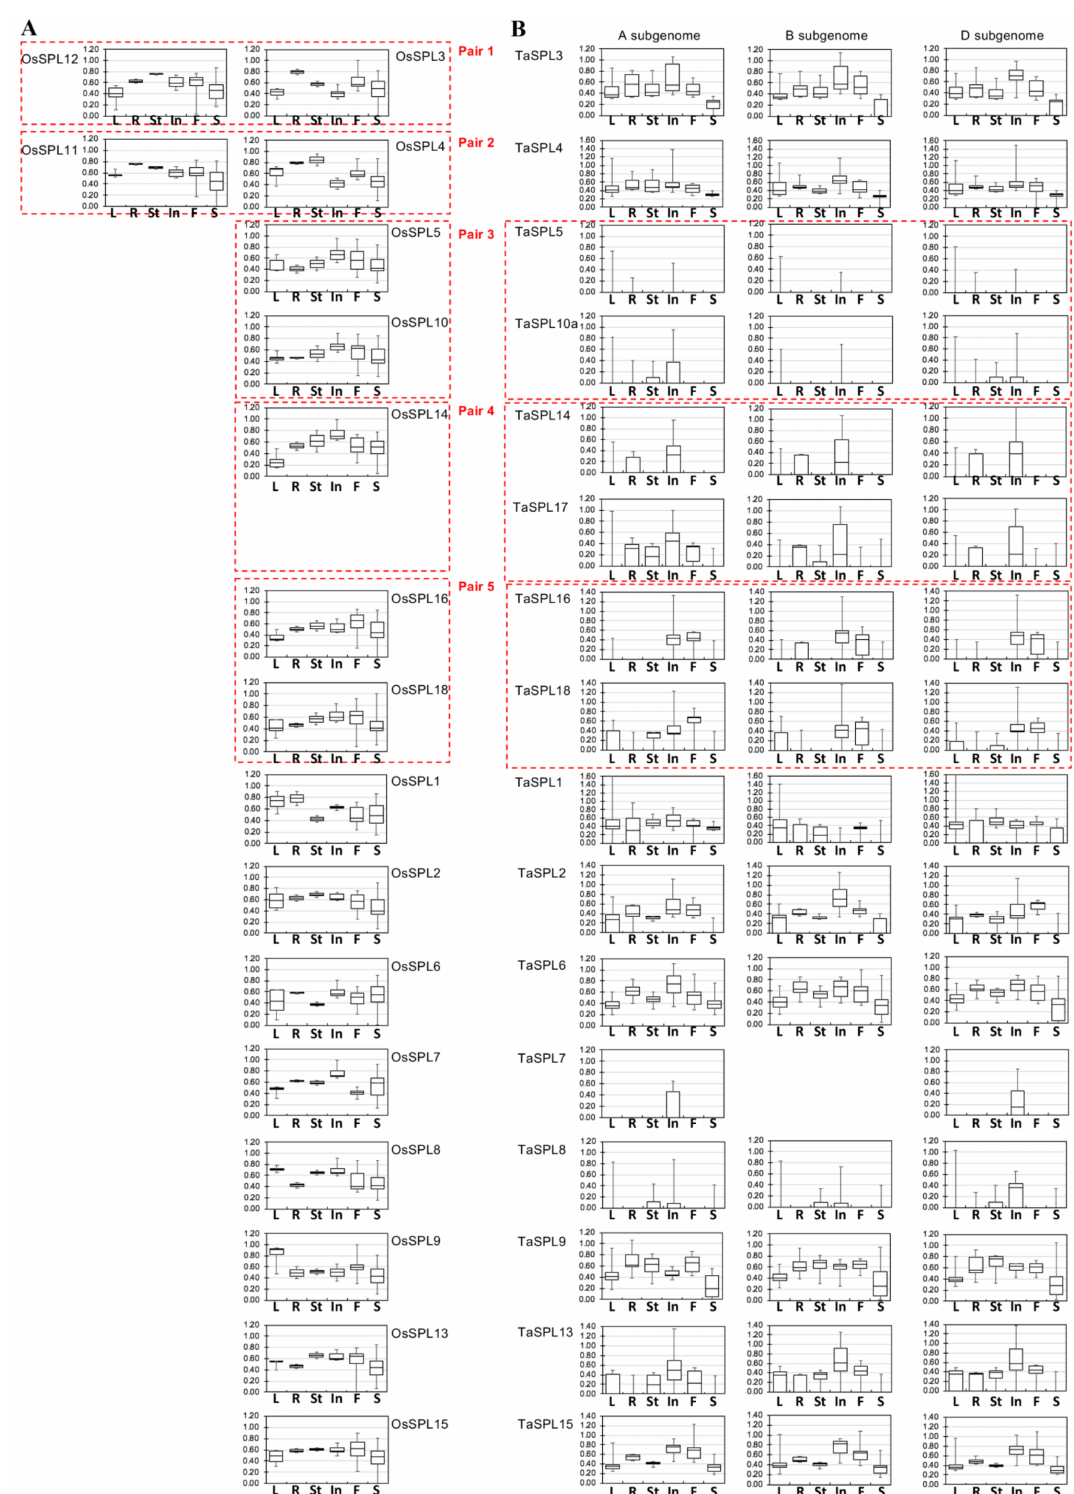
Figure 3. Summarized expression patterns of OsSPL s ( A ) and their orthologous TaSPL s ( B ). The SPL genes are listed first by paleoduplicated pairs and then singletons, with the duplicated pairs of SPL s indicated in red boxes. OsSPL expression profiles are from microarray data (Figure S7) and summarized in terms of tissues (L: leaves; R: roots; St: stems; In: inflorescence; F: flower organs; S: seed tissues), while the TaSPL expression profiles were retrieved from publicly available RNA-seq results (details in Methods